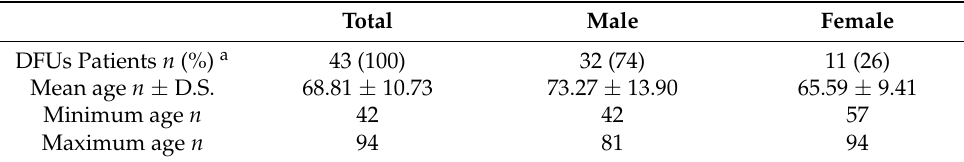
Table 1. DFUs population gender and